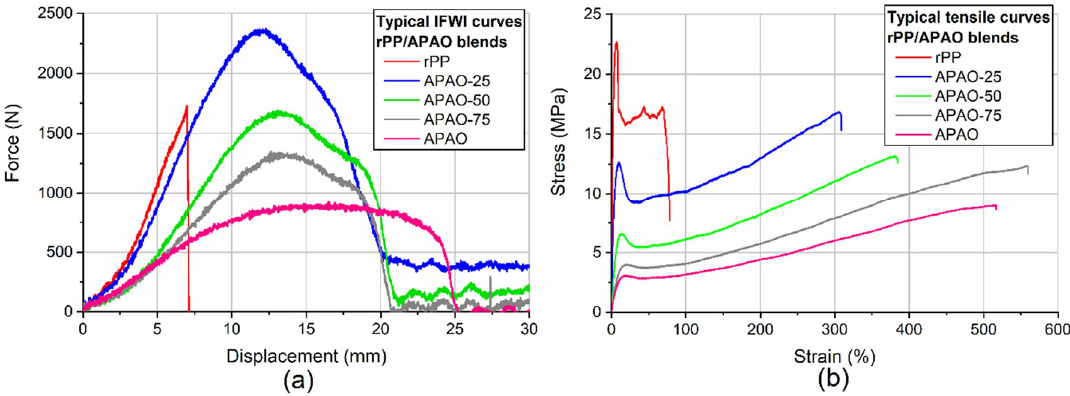
Figure 4. Typical ( a ) IFWI and ( b ) tensile curves of the rPP / APAO blends. Table 2. Mechanical properties of the matrix blends and their films.